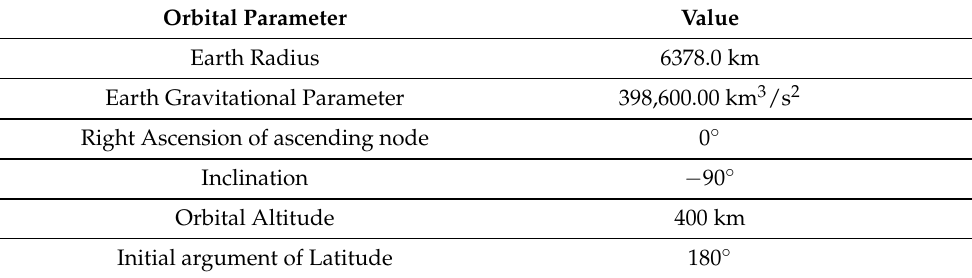
Table 1. Orbital Parameters for Reference Frame, Values obtained from [20].